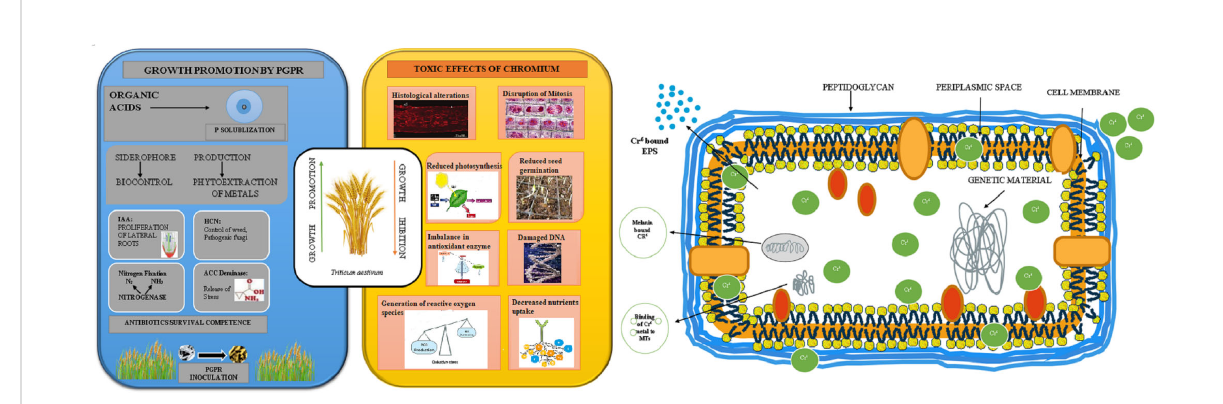
FIGURE 3 A schematic illustrating how rhizobacteria that encourage plant growth might boost growth and reduce the damaging effects of chromium (Cr) on plant. The removal/detoxi fi cation of Cr ions by active biomolecules i.e., secretion of melanin, metallothionein (MTs), and polymeric